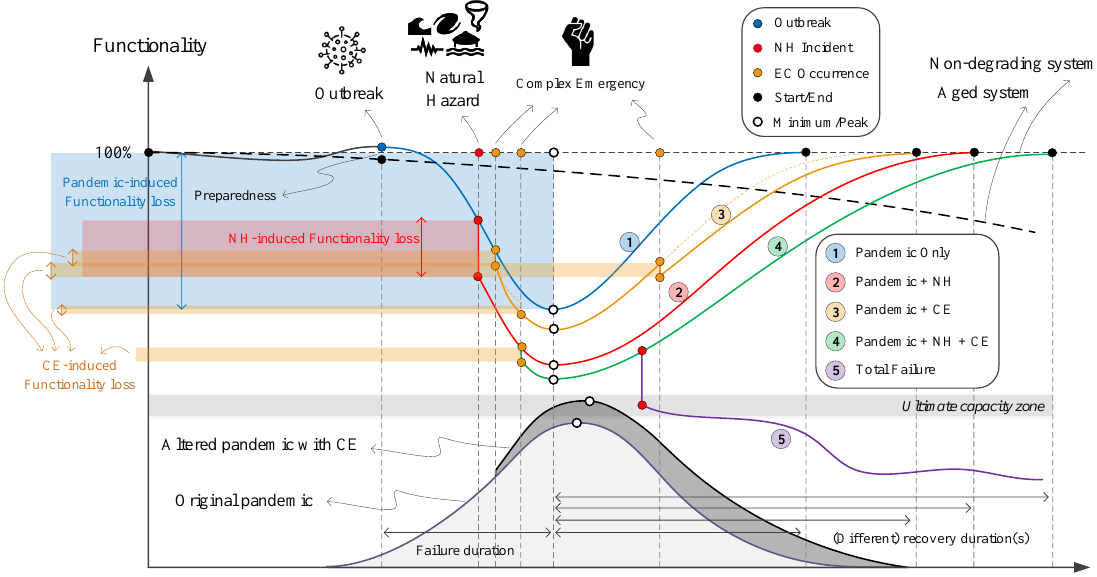
Figure 5. Response and recovery of healthcare system under multi-hazard scenarios during pandemic; Five color lines present the response/recovery of the healthcare system; color (red, blue and yellow) circles show the occurrence of three hazard sources; the black circle shows the start and end point of the resilience curves; the white circle presents the minimum resiliency (or peak pandemic); the light and dark gray bell shapes are the pandemic progress over time in the original form and altered by CE, respectively; and finally, the colored transparent rectangle on the top left side of the figure presents the individual/cumulative functionality